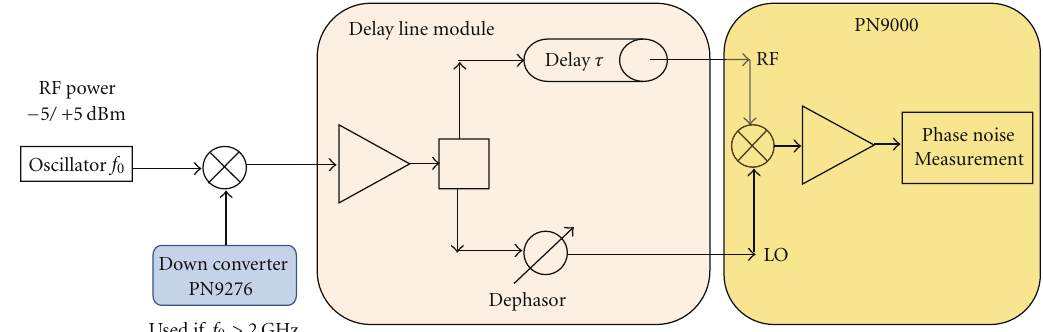
Figure 23: Synoptic of PN9500 phase noise bench.